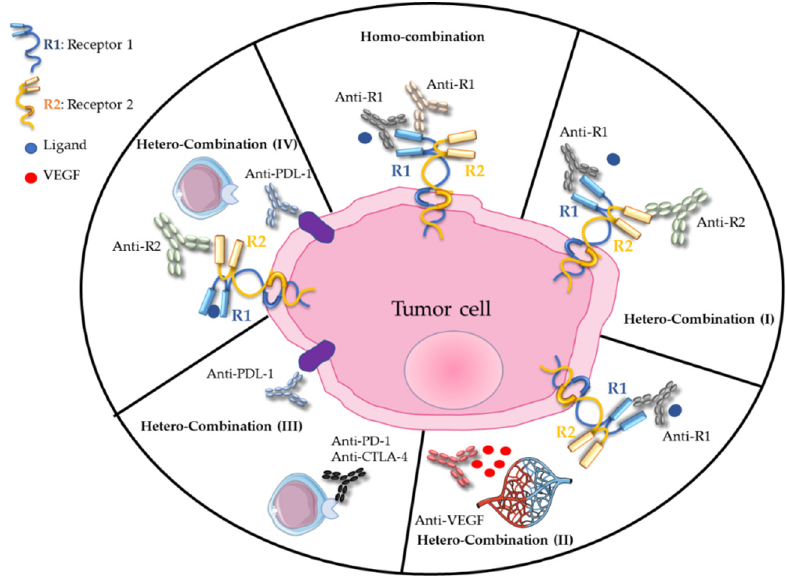
Figure 1. Homo- and hetero-combinations of monoclonal antibodies, adapted from [15]. In 2007, our team demonstrated that the hetero-combination of antibodies against EGFR and HER2, two functionally collaborating receptors (Figure 1), has a higher anti- tumor effect by promoting ADCC, by reducing the expression of these receptors and homodimer formation [16–18] and also by inhibiting intracellular signaling pathways